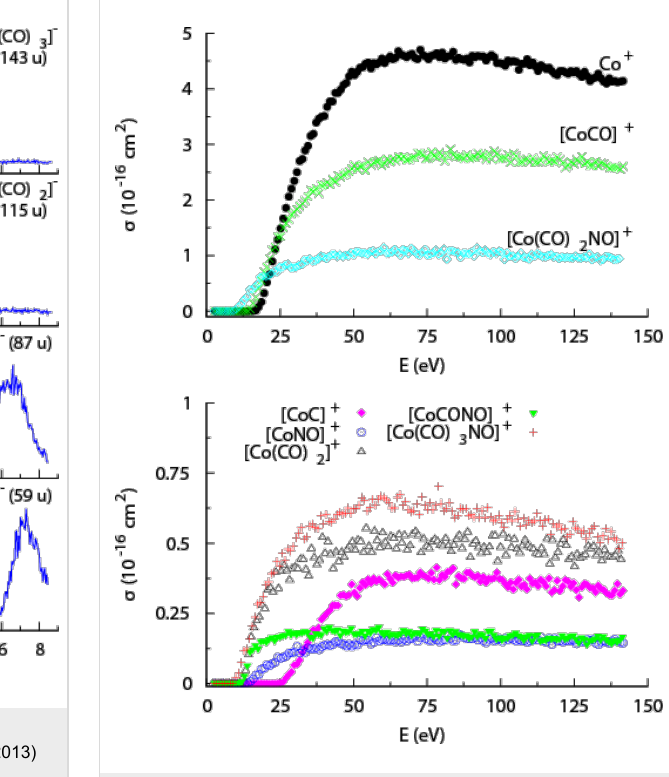
Figure 18: Energy dependence of the partial cross sections for posi- tive ion fragments formed from Co(CO) 3 NO (reproduced with permis- sion from [10], Copyright (2013) American Institute of